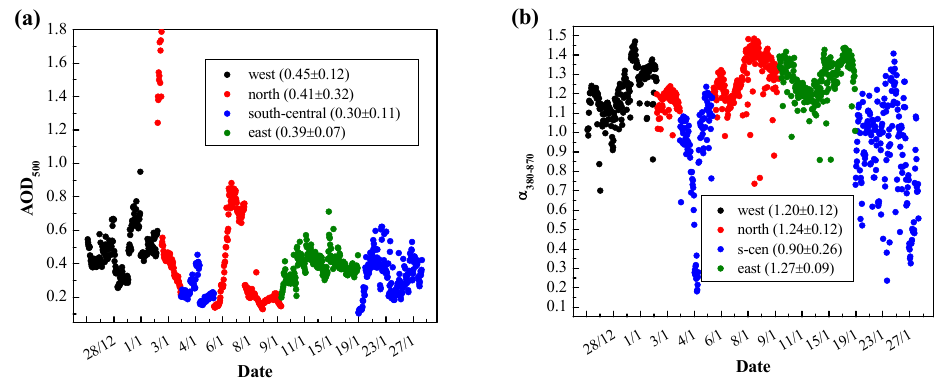
Fig. 2. Temporal variation of AOD 550 (a) and α 380 − 870 (b) values over different BoB sub-regions during W-ICARB cruise campaign. The mean values along with the standard deviations are given for each